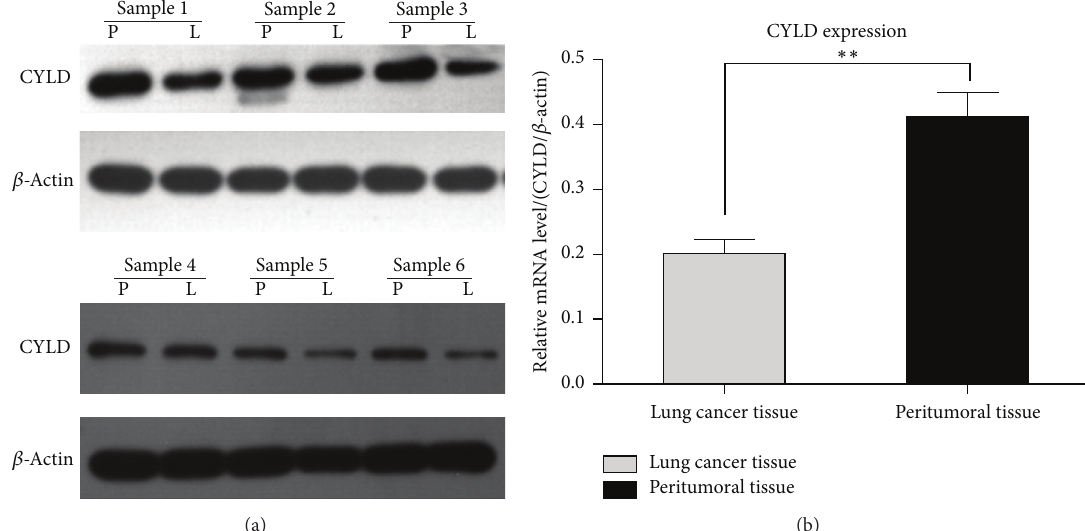
Figure 1: Lower levels of CYLD are detected in clinical lung carcinoma specimens. The surgical specimens including lung cancer tissues and the paired peritumoral tissues from the lung cancer patients were collected. (a) The expression levels of CYLD were detected by western blotting analysis. The data shown here was representative of six independent specimens. The housekeeping gene, 𝛽 -actin, was used as an internal reference in the experiment. P, paracarcinoma tissue; L, lung adenocarcinoma tissue. (b) The levels of CYLD were detected by real- time PCR assay. Ratios of CYLD/ 𝛽 -actin were shown representing the relative mRNA levels in lung cancer patients. The data was shown as mean values ± SD. ∗∗ 𝑝 < 0.01 compared with peritumoral